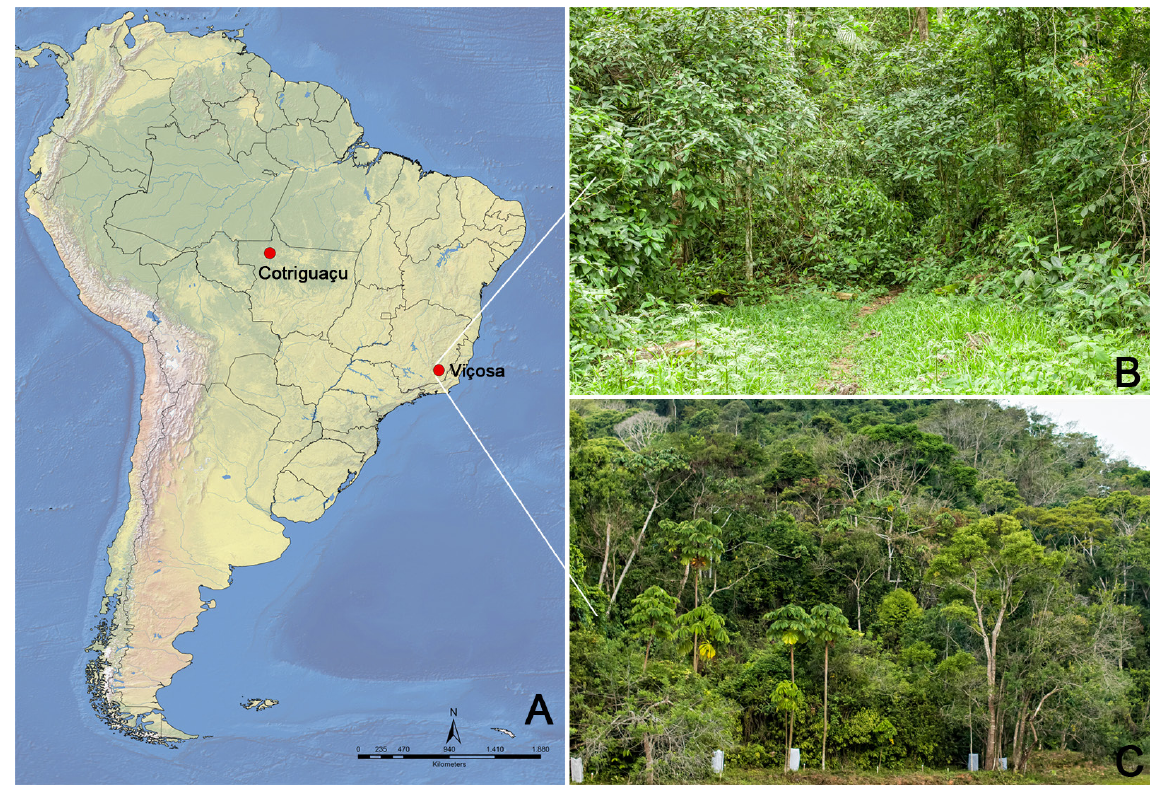
Fig. 46. A . Distribution map of species of Cyparium Erichson, 1845, South America. B . Mata da Biologia. C . Mata do